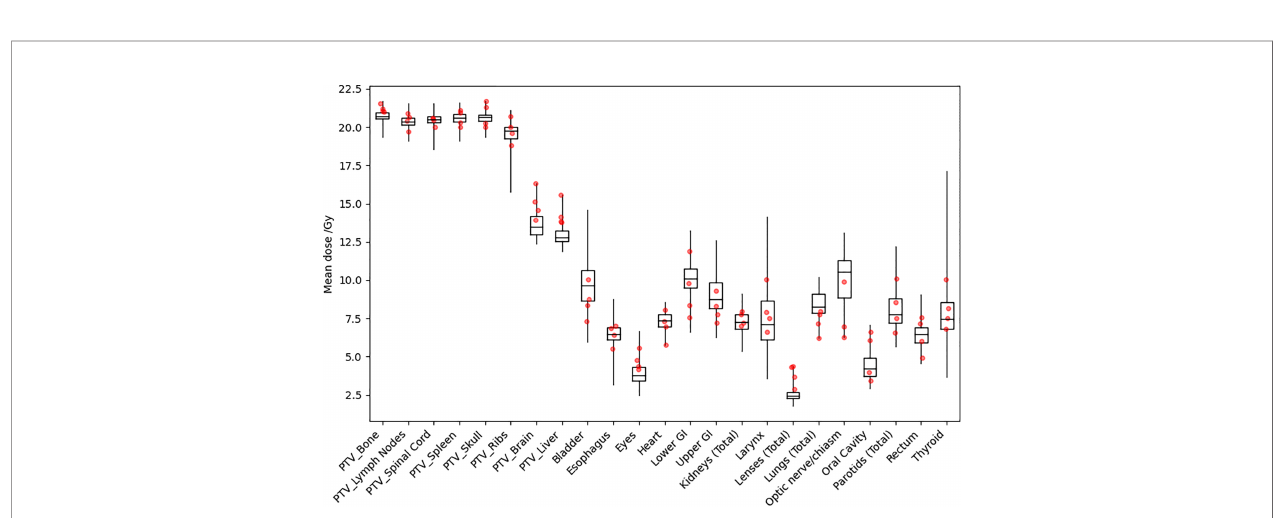
FIGURE 5 | Distribution of mean dose (Dmean) for target volumes and major normal organs in the 20-Gy cohort. The median value of Dmean for each structure is shown at the horizontal bar in the middle of each rectangle. The 1st and 3rd quartiles are shown as the lower and upper horizontal sides of each rectangle. The minimum and maximum range of Dmean is shown as the vertical lines extending from each rectangle. The red dots are Dmean data in the four VMAT TMLI treatment plans in the 20-Gy cohort.